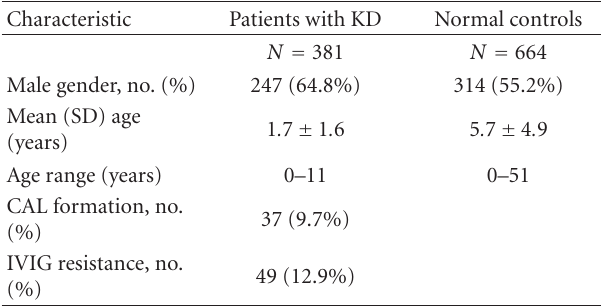
Table 1: Basal characteristics of the patients with Kawasaki disease and normal